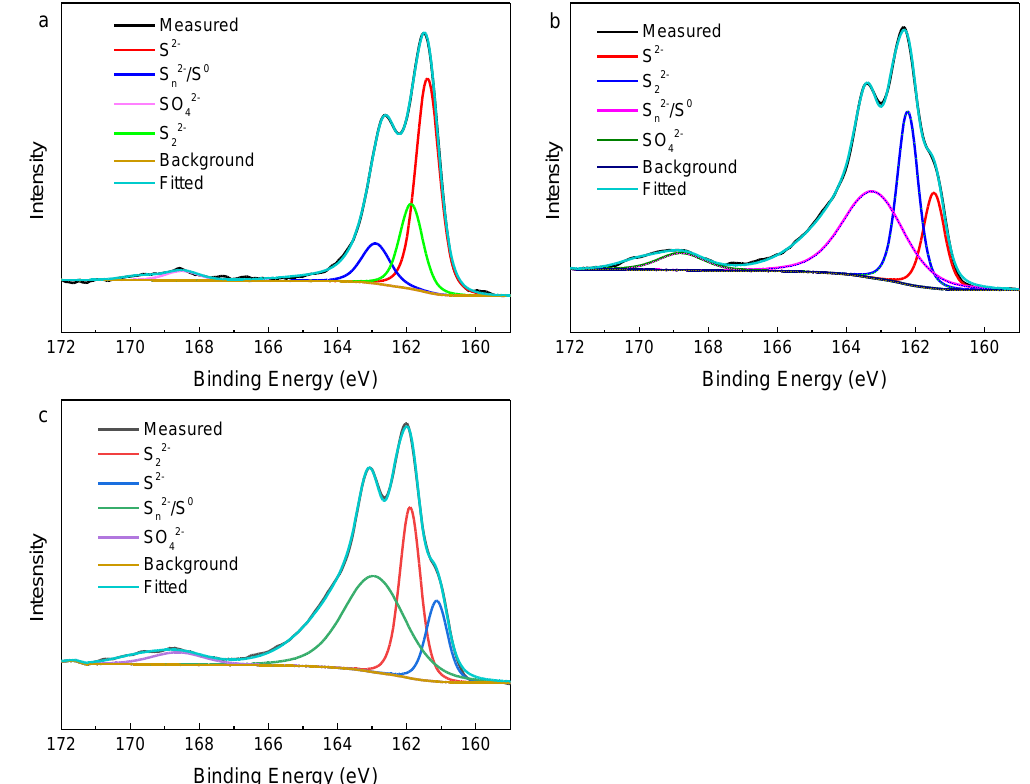
Figure 10. S 2p 3/2 XPS spectra of original bornite ( a ) and leached residues: ( b ) 7 days and ( c ) 21 days.